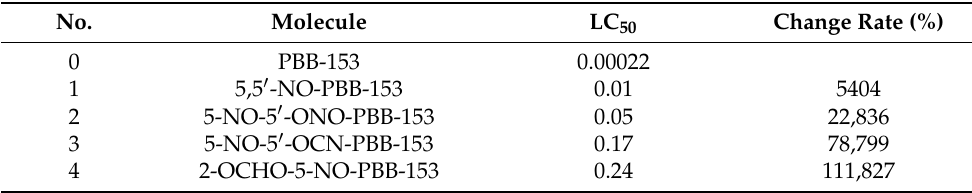
Table 6. Prediction of molecular toxicity before and after PBB-153